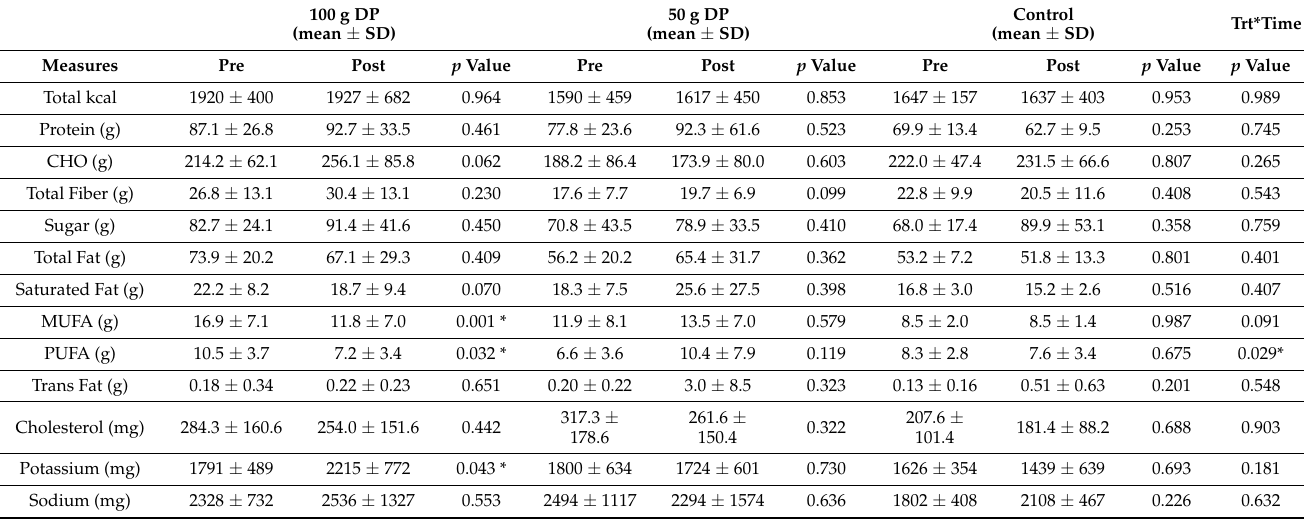
Table 4. Average dietary intake from baseline (Pre-) to 3 months (Post).